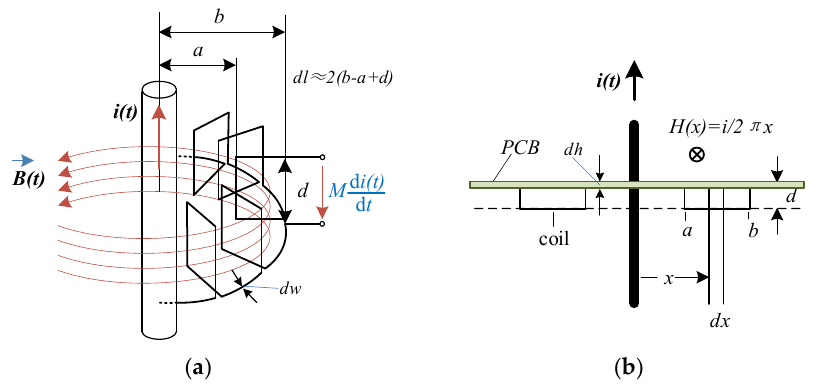
Figure 2. PCB Rogowski coil structure. ( a ) PCB Rogowski 3D structure diagram. ( b ) PCB Rogowski coil cross-section diagram.